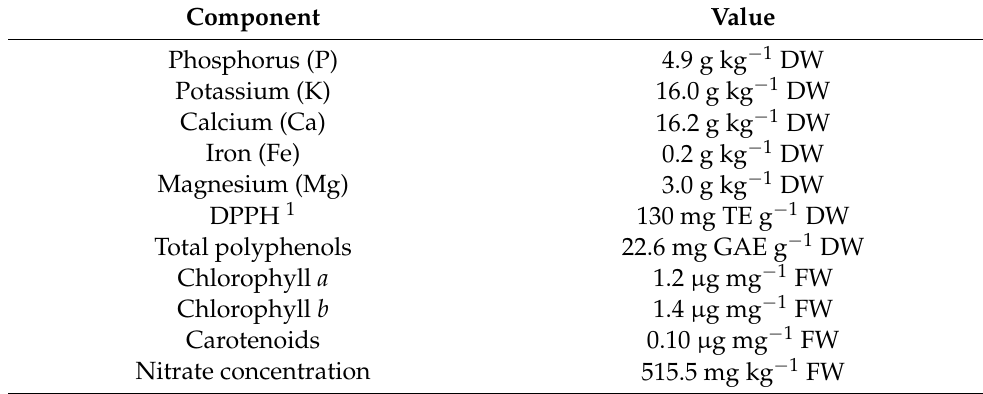
Table 1. Chemical composition of principal component of Moringa oleifera